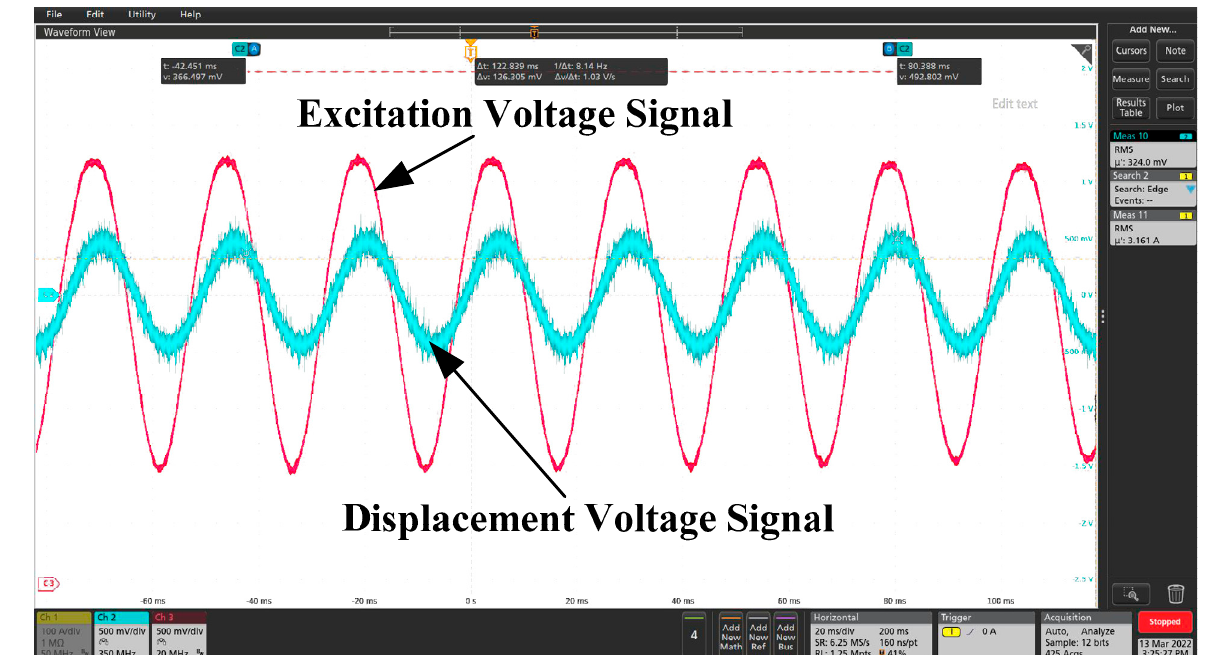
Figure 15. Test device and signal acquisition.